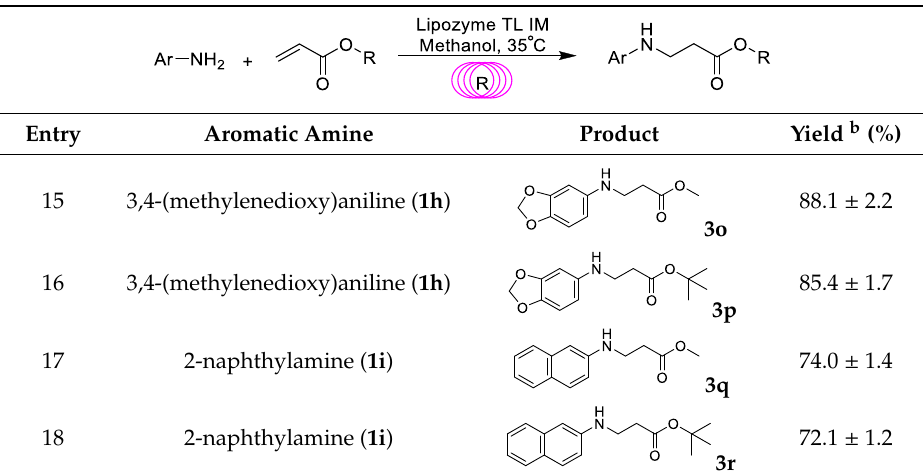
Table 4. Continuous-flow synthesis of β-amino acid esters by enzymatic Michael addition of Table 4. Cont. aromatic amines.